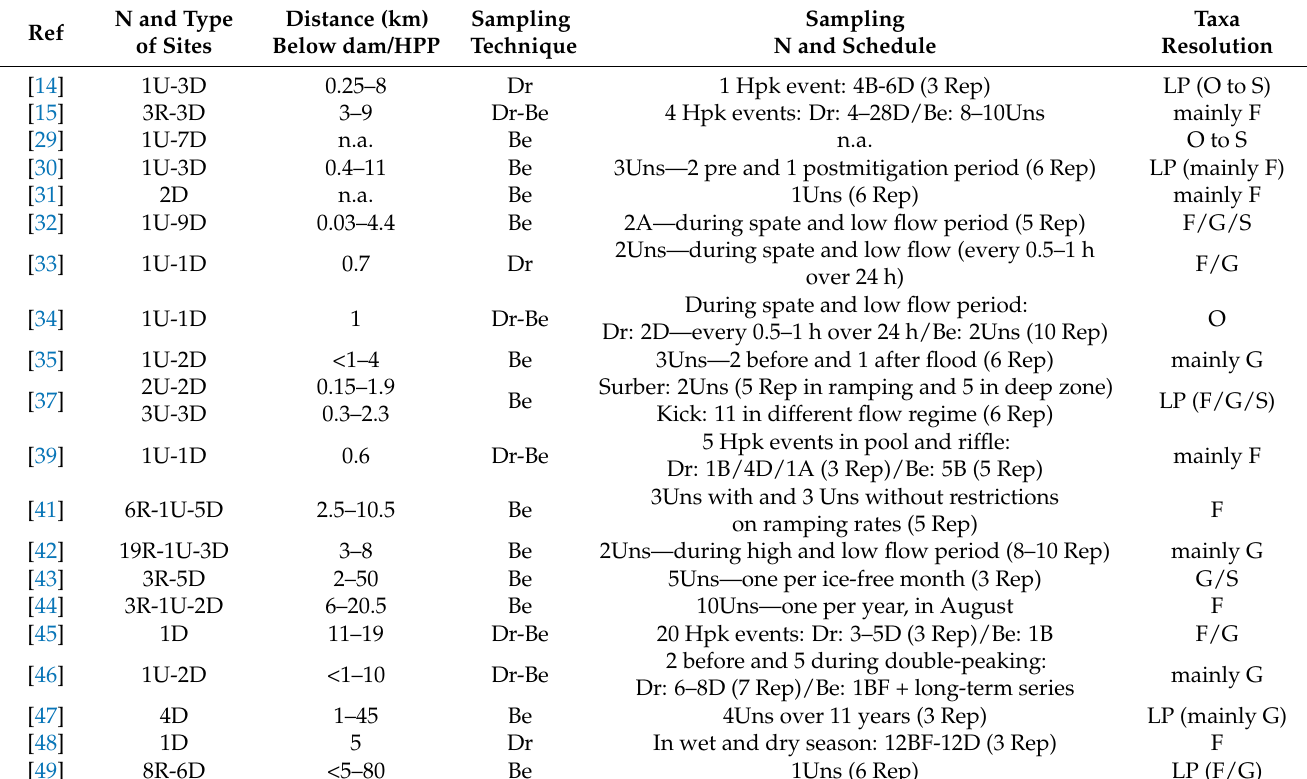
Table 4. Direct methods: main characteristics of the study design and methodology. Ref = reference; type of sites: U = upstream, D = downstream, R = reference, i.e., a site in an unimpacted river different from the river where downstream sites are located; sampling technique: Dr = drift, Be = benthic; sampling schedule per each site: Hpk = hydropeaking, B = before hydropeaking, D = during hydropeaking, A = after hydropeaking, Uns = unspecified, BF = base flow, Rep = replicates; taxa resolution: O = order, F = family, G = genus, S = species, LP = lowest possible; n.a. = not